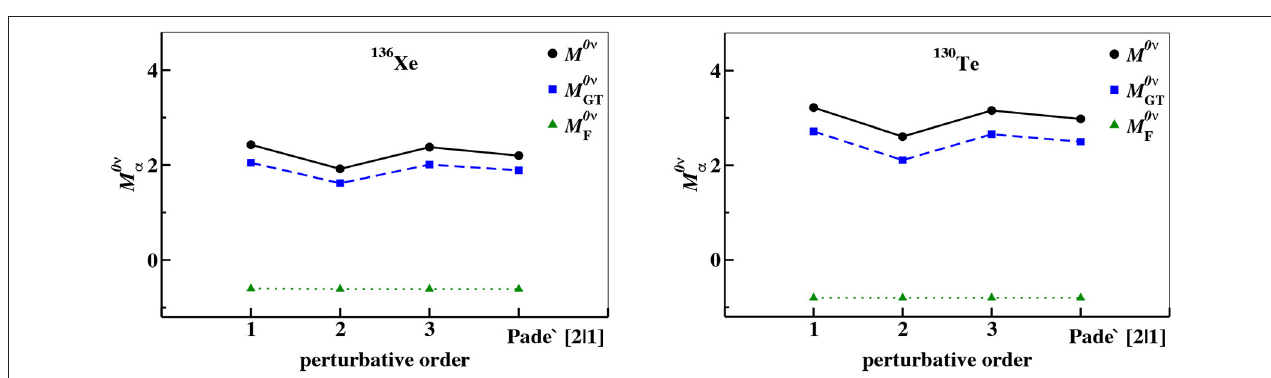
FIGURE 18 | Calculated M 0 ν values for the 136 Xe → 136 Ba decay (left) and the 130 Te → 130 Xe decay (right) as a function of the perturbative order. The green triangles correspond to M 0 ν F , the blue squares to M 0 ν GT , and the black dots to the full M 0 ν . Reproduced from reference [89].